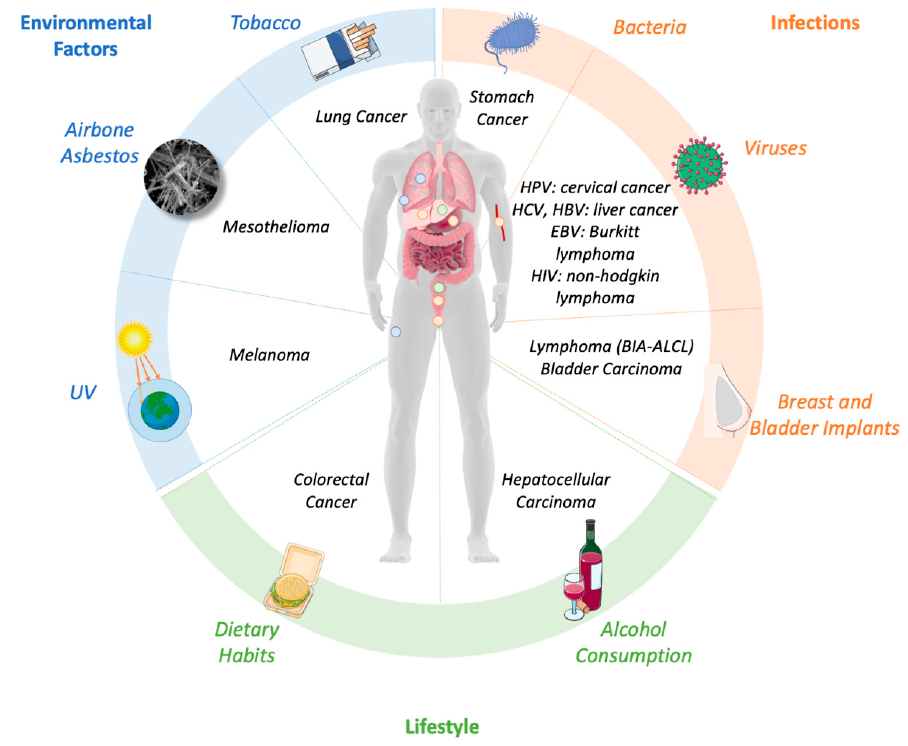
Figure 2. The main triggers of chronic inflammation. Environmental factors, lifestyle habits and infections induce chronic, unleashed inflammation that are able to increase the risk of different tumor types. This figure was made with Servier Medical Art templates, which are licensed under a Creative Commons Attribution 3.0. Unported License (https://smart.servier.com)